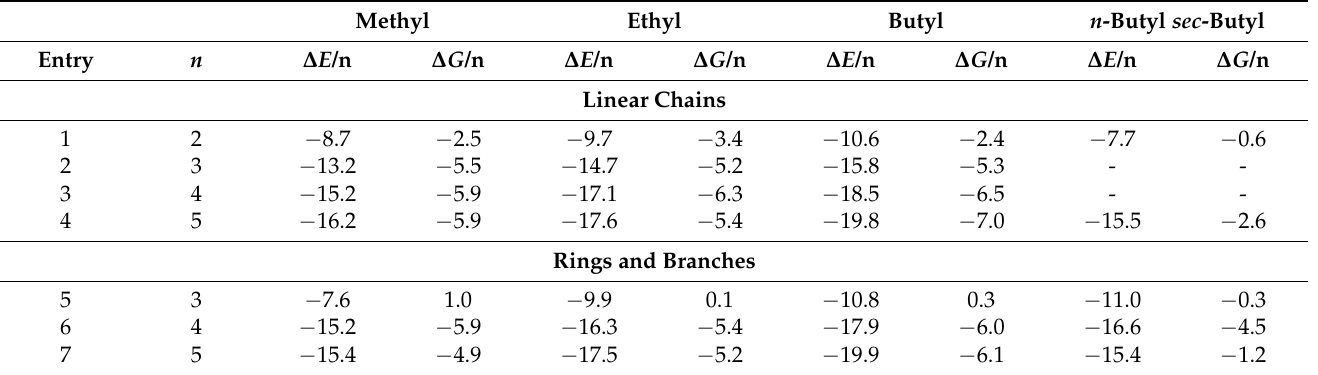
Table 3. Formation energies and free energies per monomer, ∆ E /n and ∆ G /n, for the possible aggregates depicted in Figure 5. The energies are shown for the formation of linear chains and both the other aggregation ways, the ring-like oligomer formation or branches within linear chains. Methyl Ethyl Butyl n -Butyl sec -Butyl